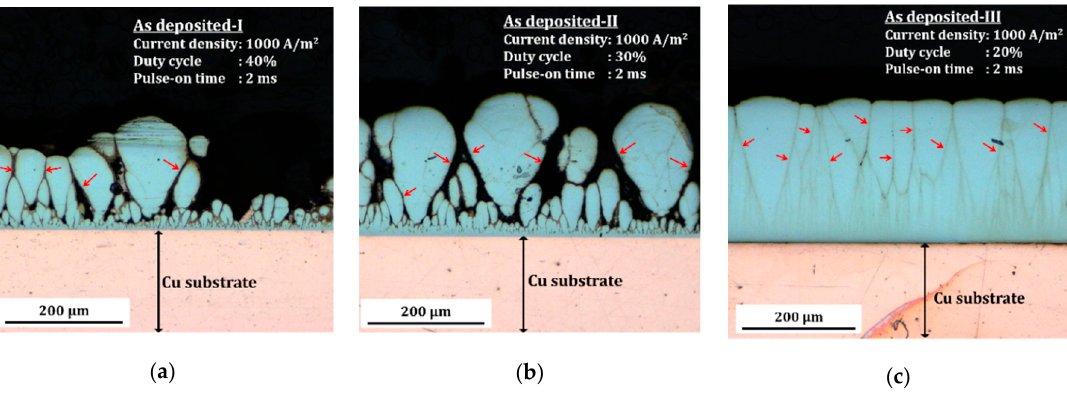
Figure 1. Cross-sectional images of nanocrystalline Co-Cu deposited at various duty cycle of ( a ) 40%, ( b ) 30%, and ( c ) 20% at a pulse current density of 1000 A/m 2 and a pulse-on time of 2 ms. The films were deposited at the same number of pulse cycles for different time of deposition which are ( a ) 13 h, ( b ) 8.5 h, and ( c ) 6.5 h to obtain the 300 µm of thicknesses (current efficiency 80–90%).